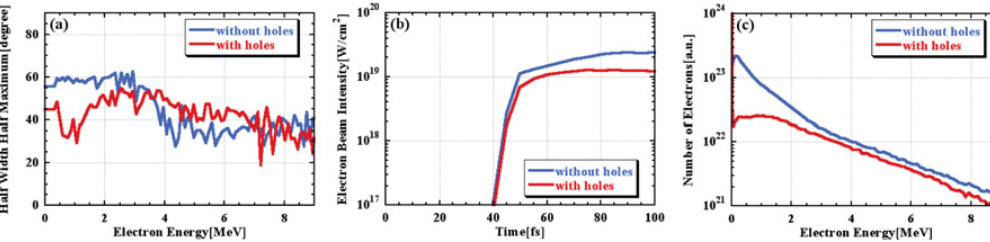
Figure 6. Fast electron characteristics for without or with punched out holes: (a) half width half maximum of divergence at 100fs, (b) time evolutions of fast electron beam intensity and (c) time integrated fast electron energy